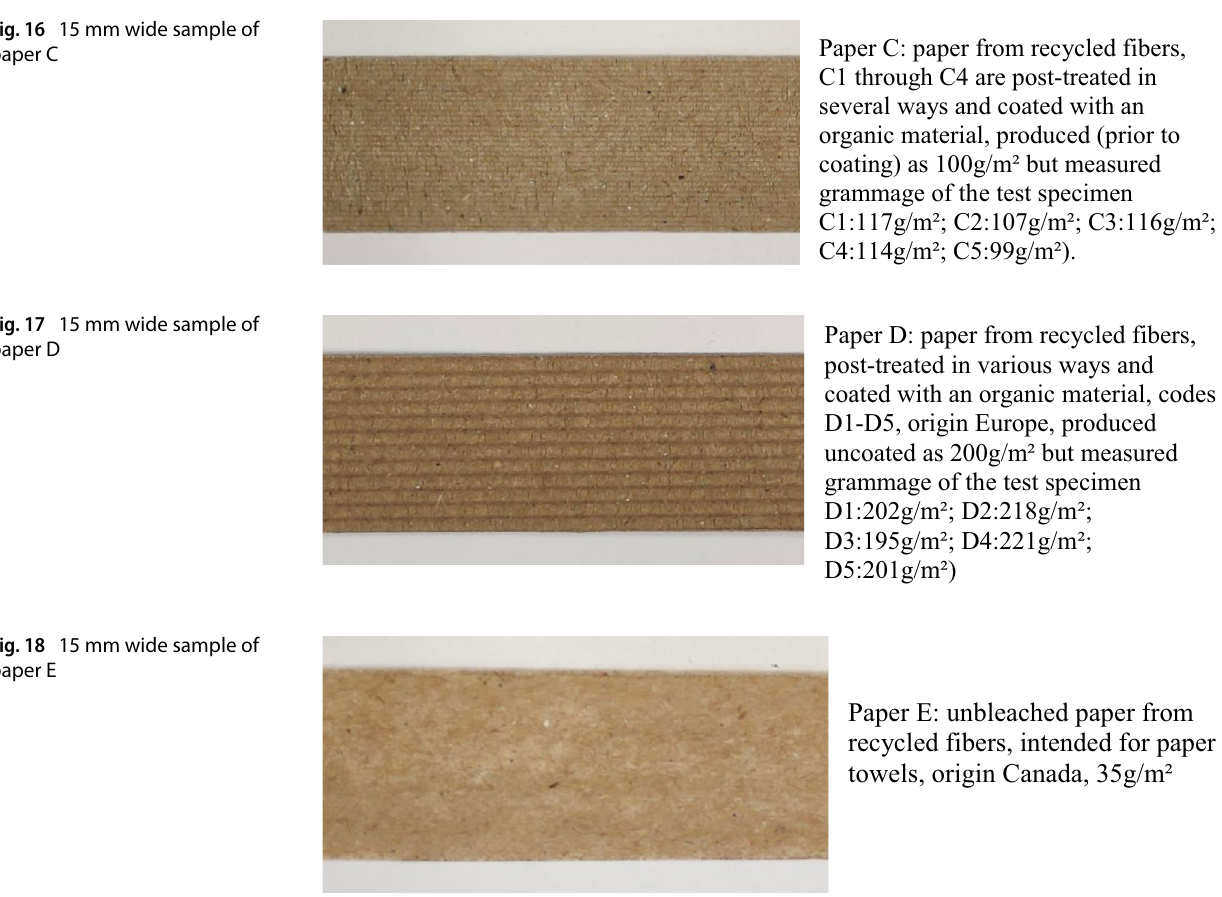
Fig. 16 15 mm wide sample of paper C